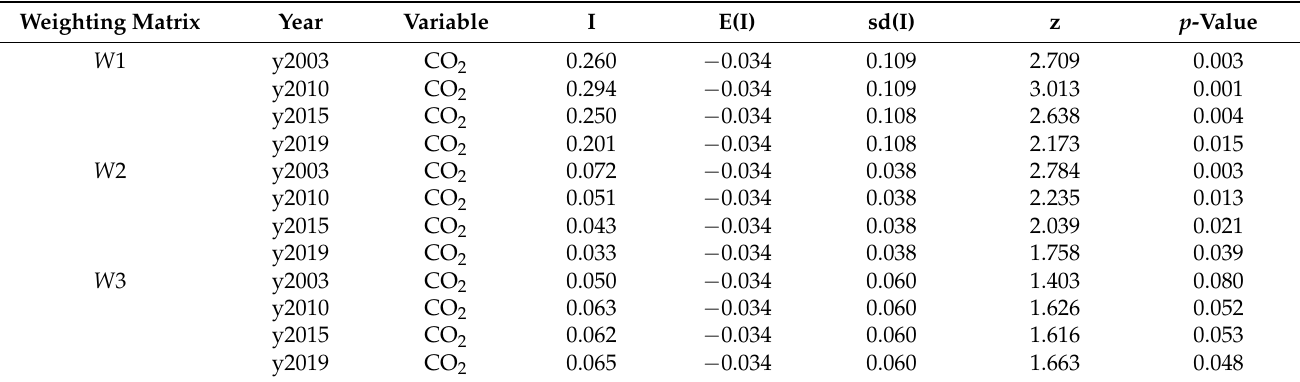
Table 5. Moran’s I index of carbon emissions under each spatial weight